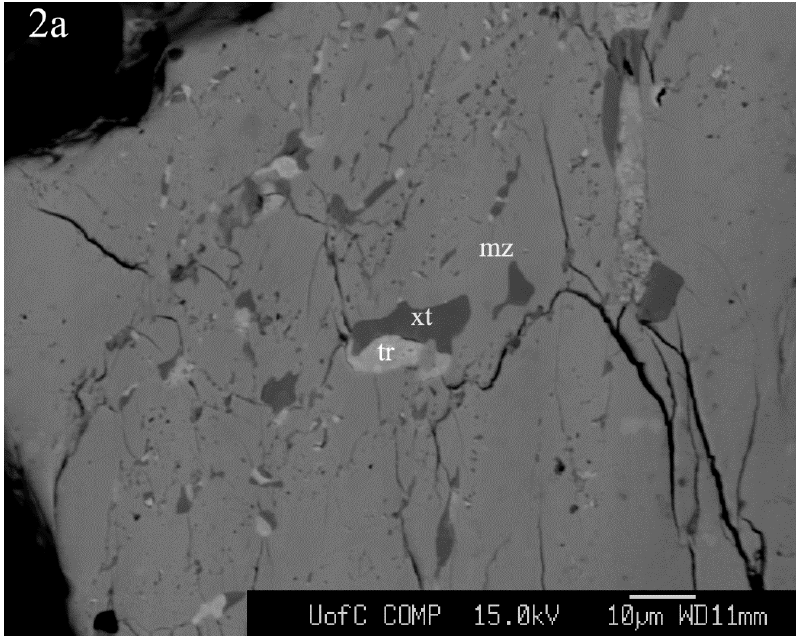
Figure 10. Back-scattered electron (BSE) image of sample 2a shows chemical heterogeneity: tr = thorite (light gray), mz = monazite (gray), xt = xenotime (dark gray). tr = thorite (light gray), mz = monazite (gray), xt = xenotime (dark